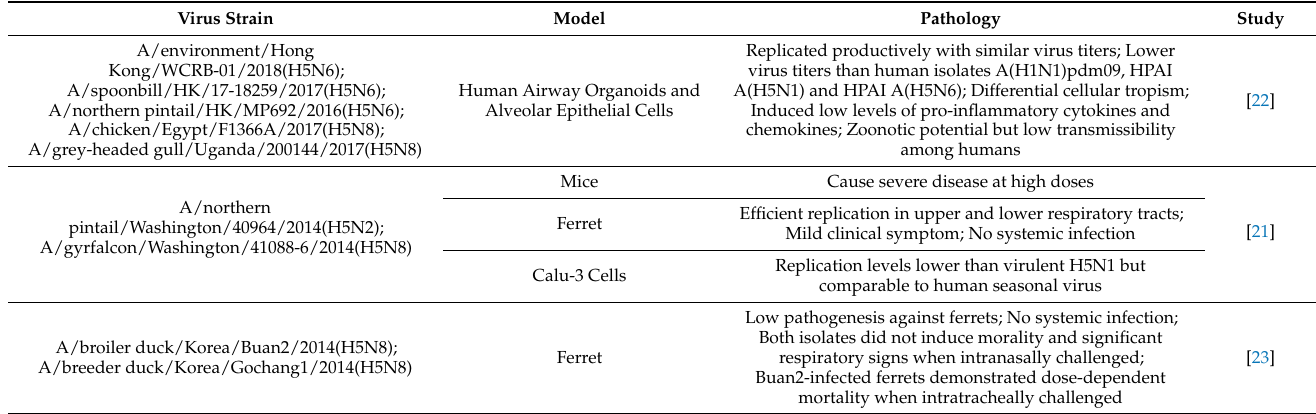
Table 1. Studies on H5Nx viruses and their utilized